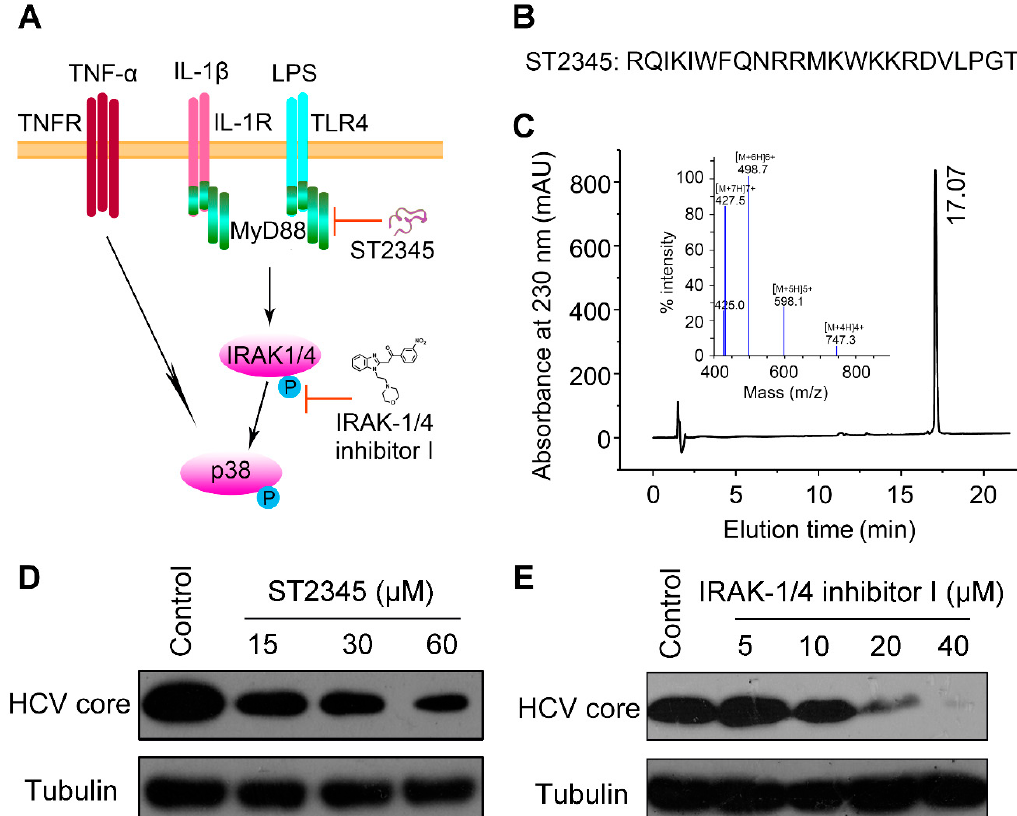
Figure 4. Inhibition of p38 activation suppresses HCV replication in vitro. ( A ) Schematic diagram of the p38 MAPK signal pathway and its inhibiting by ST2345 (MyD88 inhibitor) and IRAK-1/4 inhibitor I (IRAK1 and IRAK4 inhibitor). ( B ) Amino acid sequence of ST2345. ( C ) Mass spectrometry and HPLC analysis of ST2345 (1 μ g/ μ L). ( D , E ) The inhibition of ST2345 and IRAK-1/4 inhibitor I on HCV infection. Huh7.5.1 cells were infected with J399EM at an MOI of 0.1, and then treated with different concentrations of ST2345 ( D ) and IRAK-1/4 inhibitor I ( E ) for 72 h, respectively. The expression